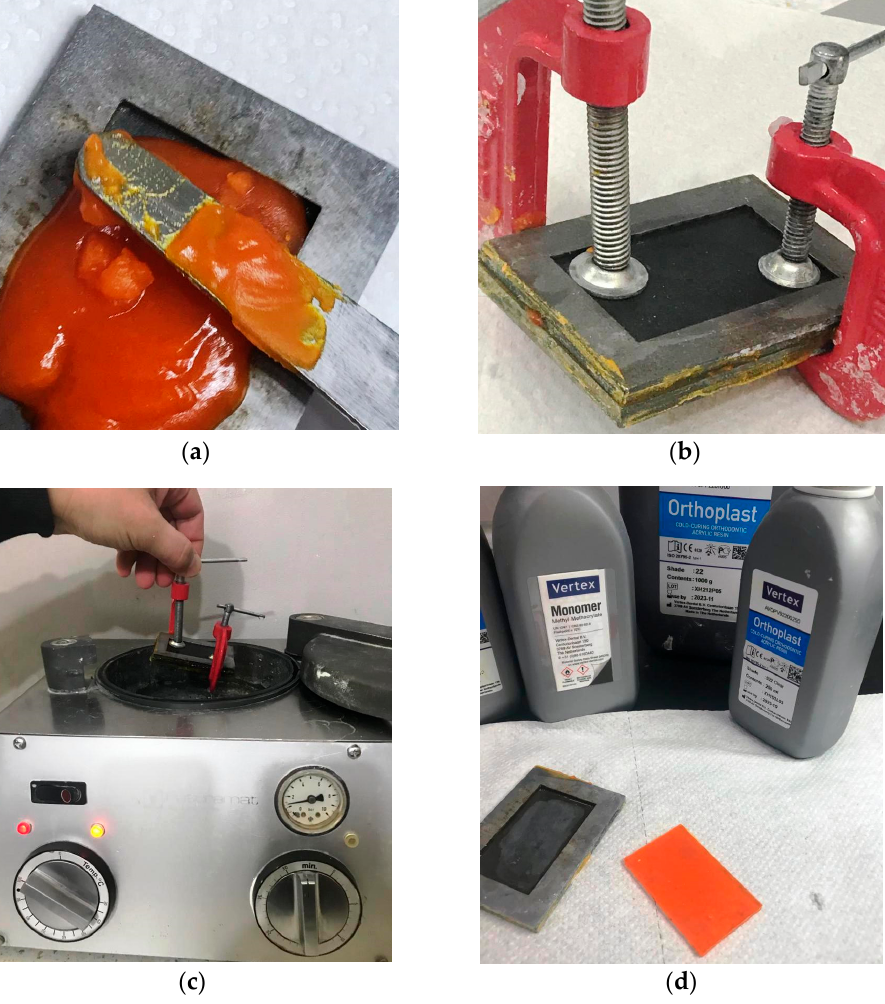
Figure 2. Preparation of the orthodontic plates by the methods of crushed dough and thermoforming: ( a ) applying a flow material 4A to a metal mold, ( b ) forming plates in a metal form, ( c ) plates polymerization equipment, ( d ) hardened orthodontic plate of 4A material after polymerization.